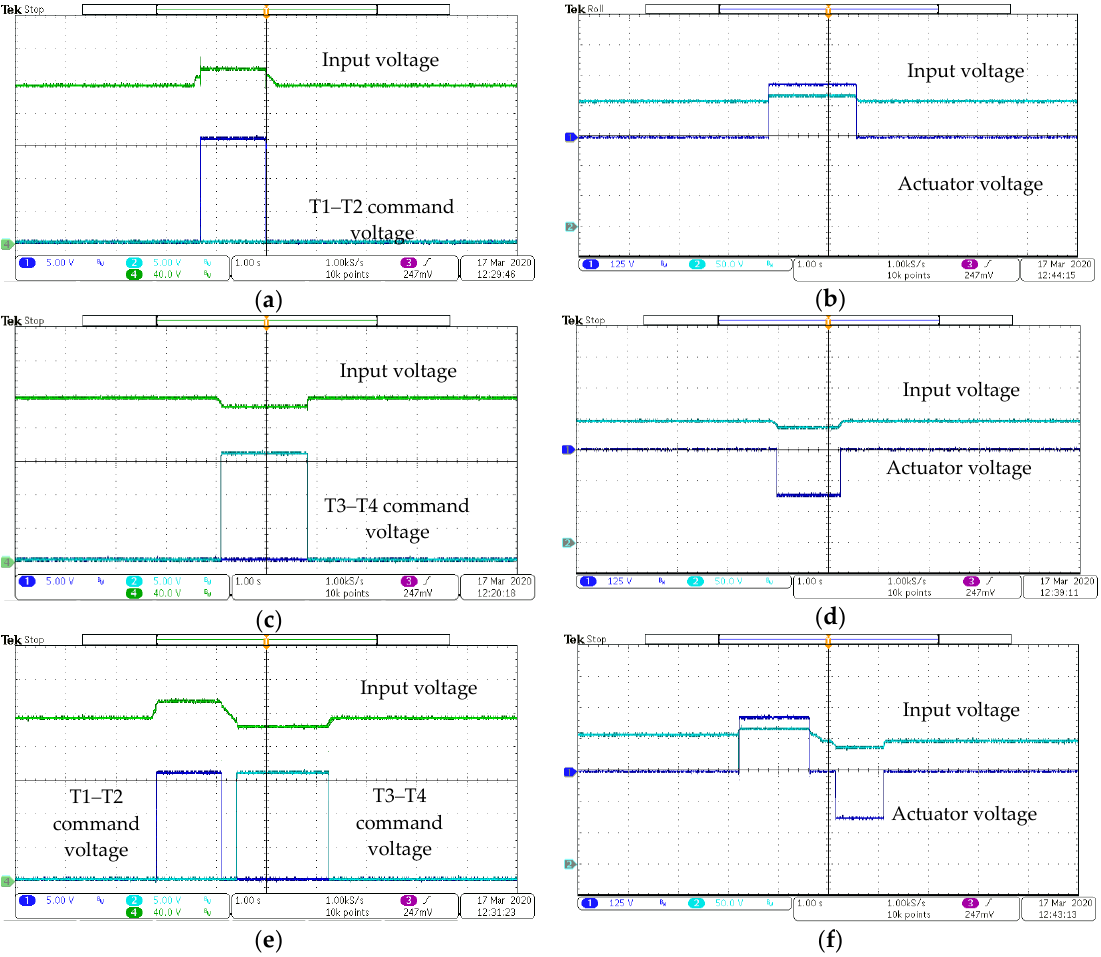
Figure 9. Working principle waveforms of the bipolar current angular command: ( a ) overvoltage transistor command signal, ( b ) overvoltage coil voltage, ( c ) undervoltage transistor command signal, ( d ) undervoltage coil voltage, ( e ) overvoltage and undervoltage transistor commands, and ( f ) overvoltage and undervoltage bipolar coil voltage.